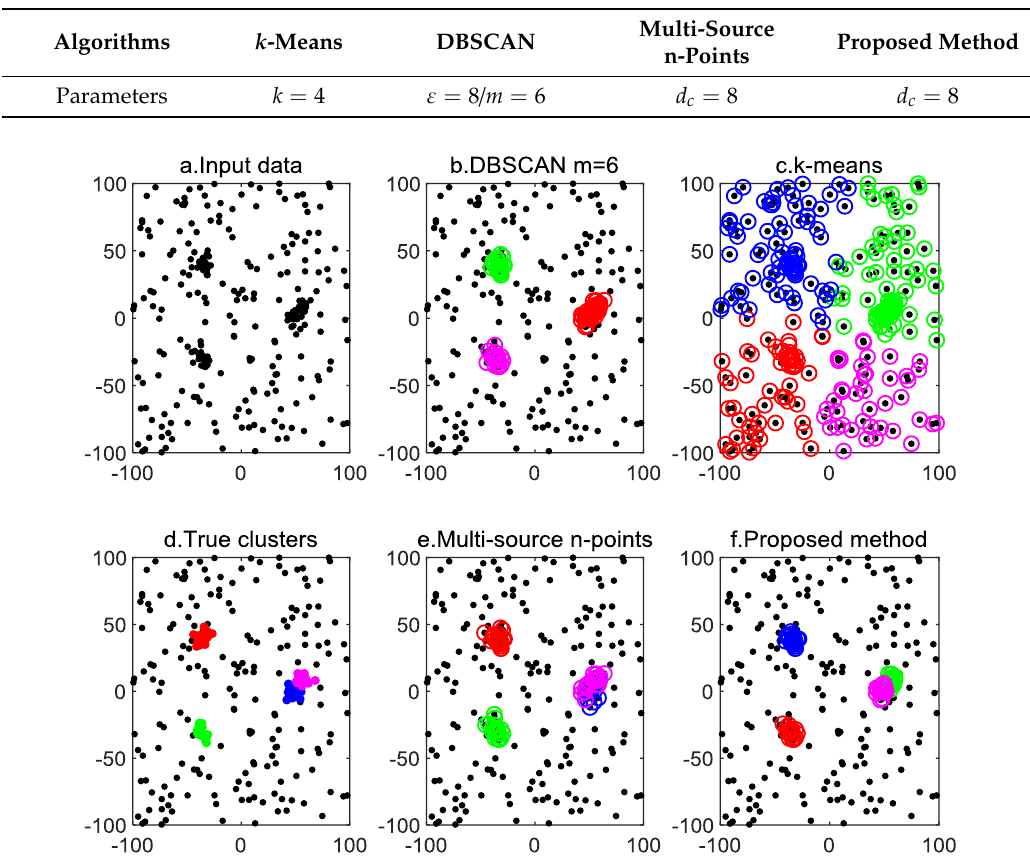
Figure 4. Outcomes of different clustering methods for data from 20 i.i.d sensors.